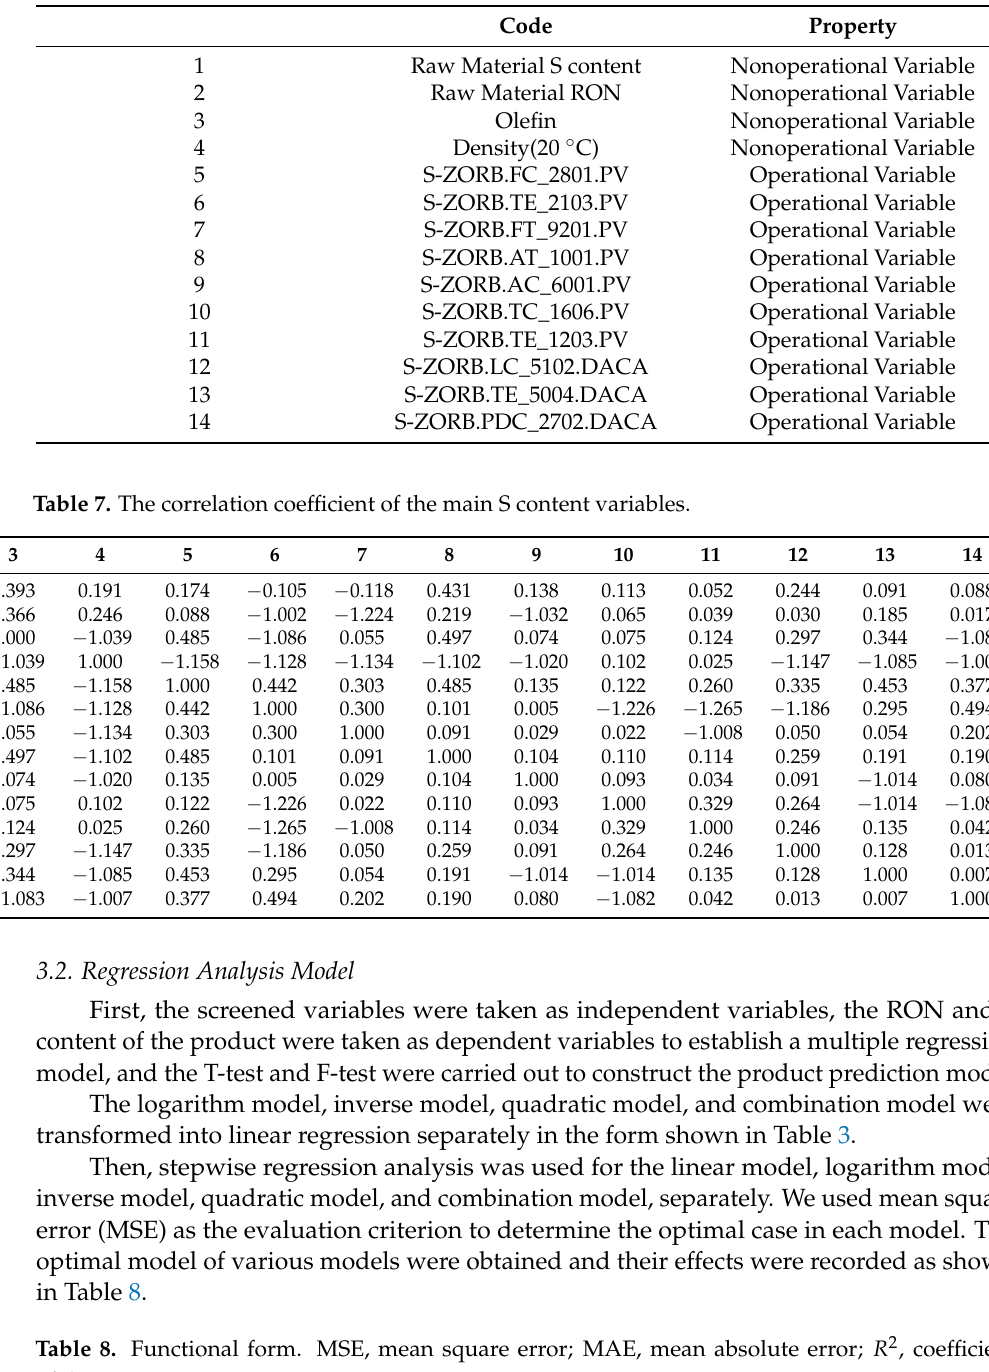
Table 6. Major S content variables.